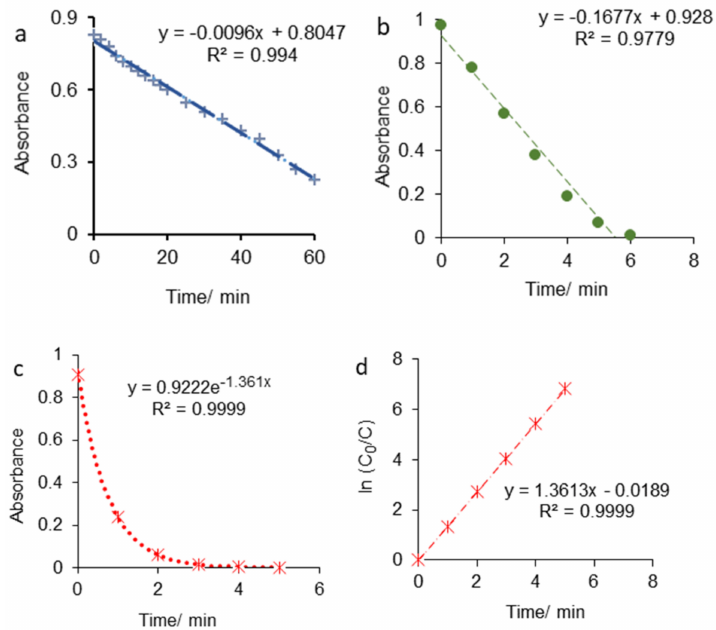
Figure 6. The kinetic models applied for CFTX degradation reaction: ( a ) in presence of F − ; ( b ) in presence of Cl − ; ( c , d ) in presence of Br − .